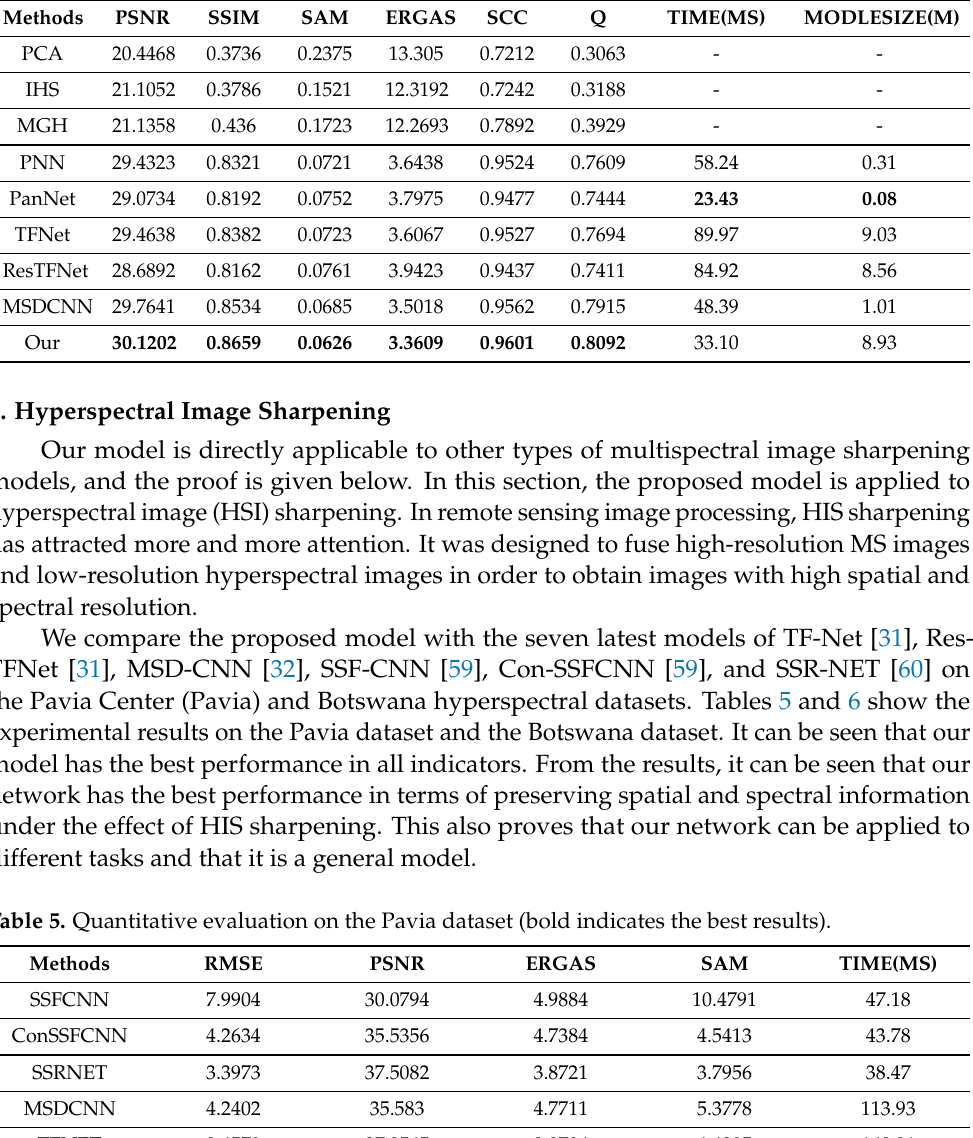
Table 4. Quantitative evaluation on the GaoFen-2 dataset (bold indicates the best results). Methods